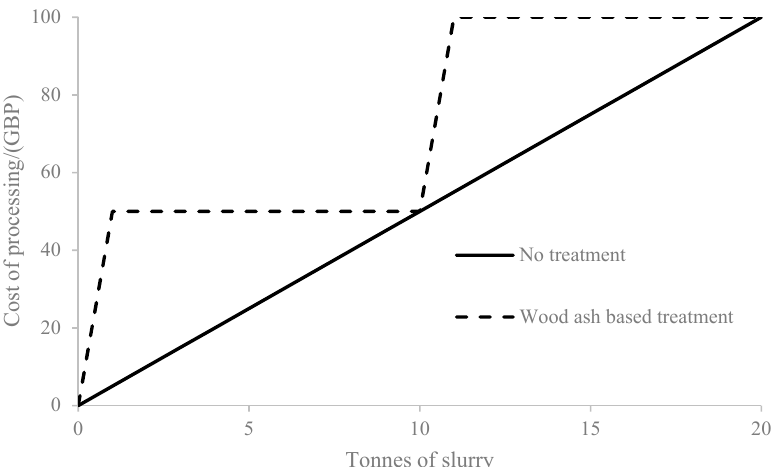
Figure 6. Comparison of the cost of processing of the proposed stabilization treatment (GBP 50/tonne fresh slurry) and the conventional land application without treatment (GBP 5/tonne).